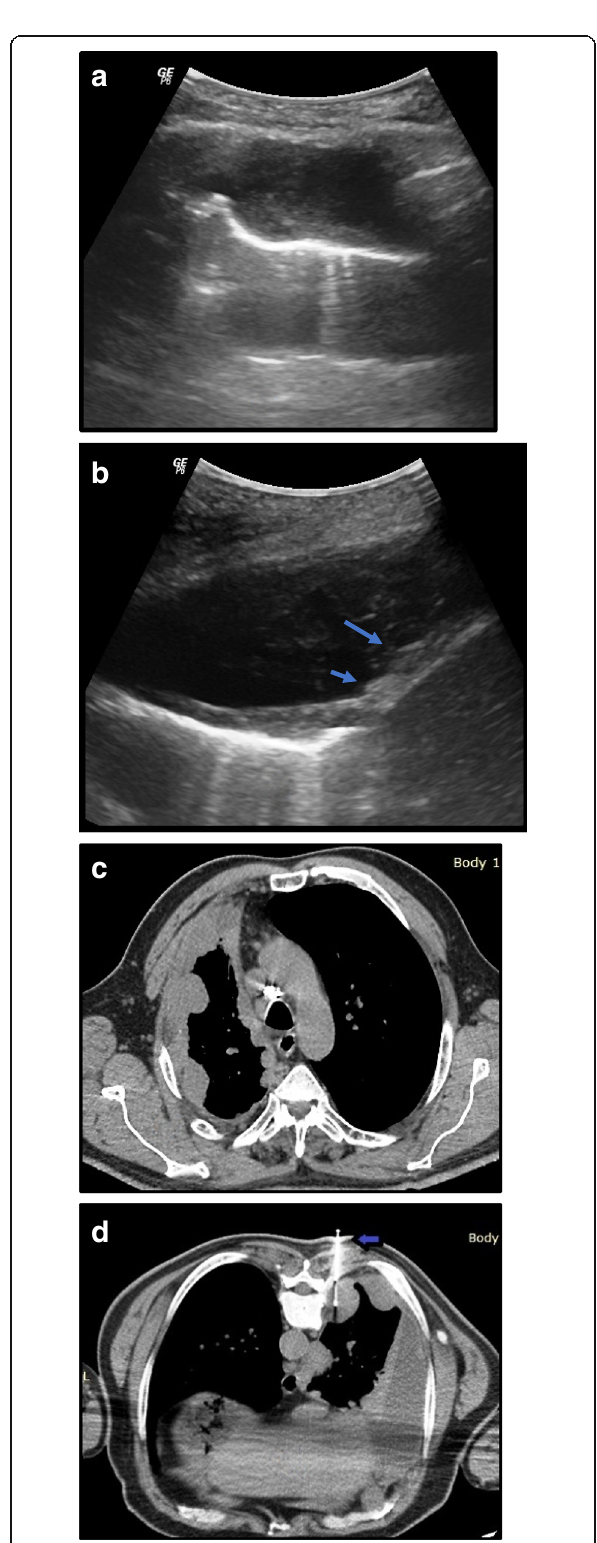
Fig. 3 US images show mild encysted complex septated pleural collection ( a ) with visceral pleural nodularity (blue arrows) ( b , c ) Non-contrasted CT chest of the same patient showed encysted pleural effusion with nodular pleural thickening and subsequent hemithoracic volume reduction. d CT-guided Tru-cut biopsy from one of the pleural nodules. Histopathology revealed